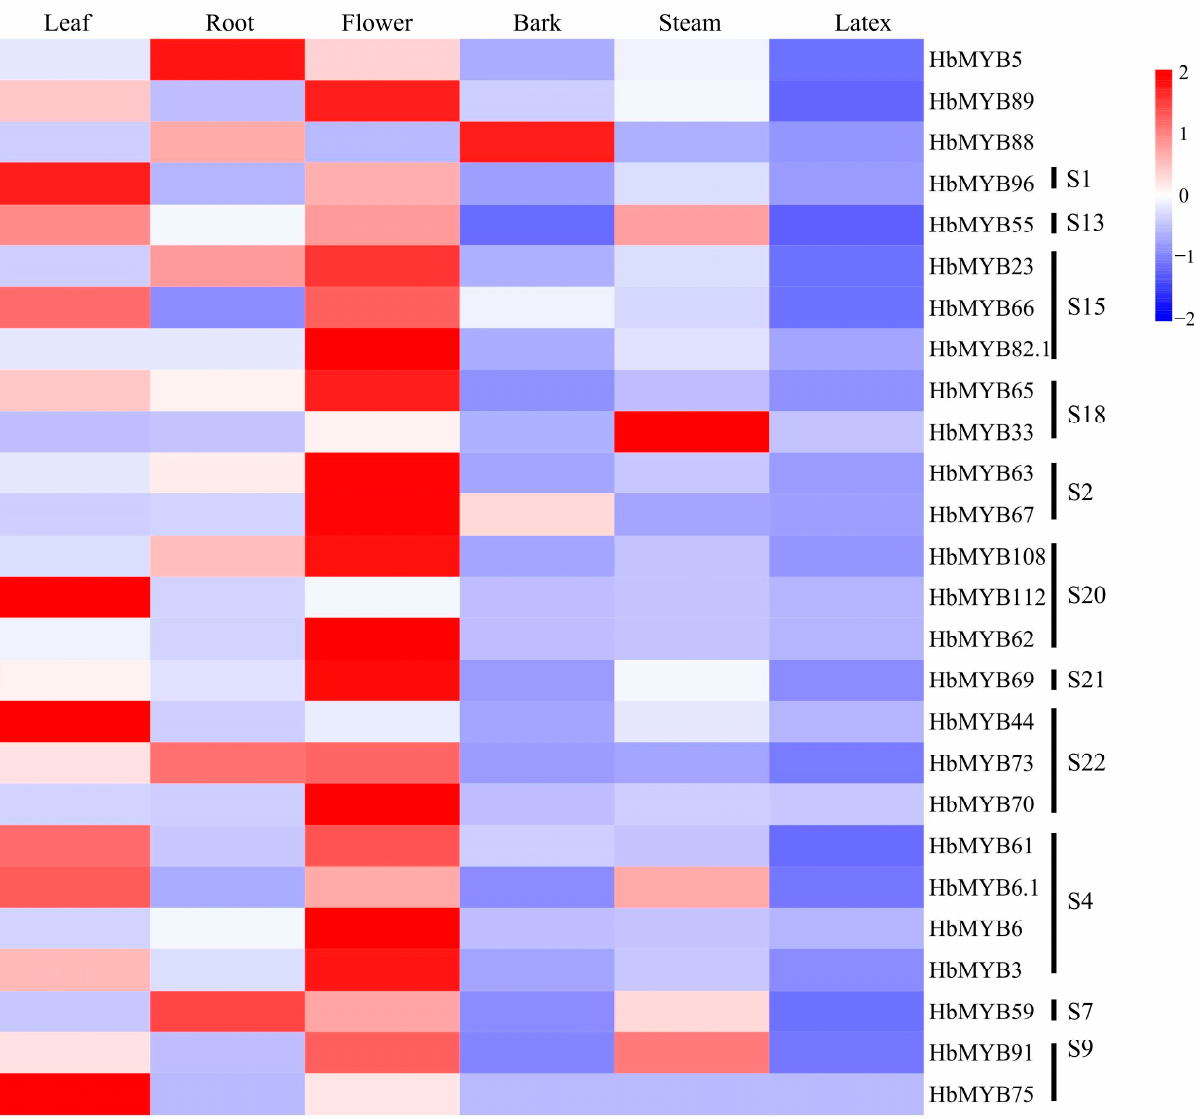
Figure 5. Tissue expression profiles of HbR2R3-MYBs in different tissues. The color bar represents the gene expression level, with red indicating high expression level, white indicating no expression, and blue indicating low expression level of transcript abundance (the same in Figures 6 and 7).